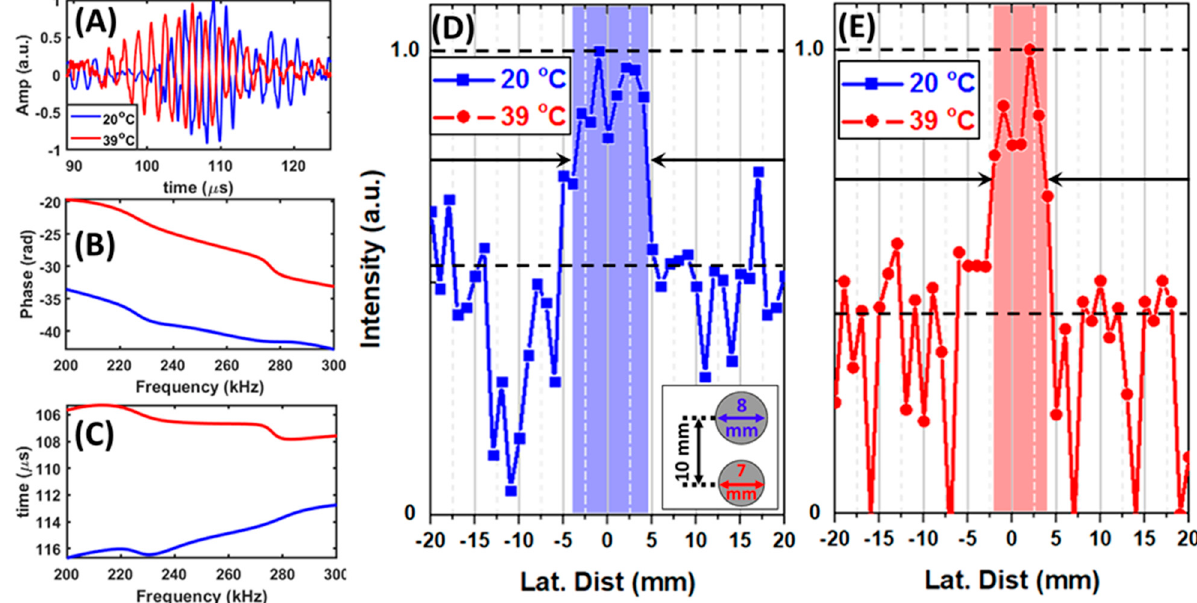
Figure 3. One-dimensional frequency-domain echo-intensity mode detection of two 3D printed ABS plastic rods in ambient water. The rods were located along the Y - (lateral) axis (Figure 2). The 7 mm diameter rod was 60 mm away from the transducer surface. The 8 mm diameter rod was 70 mm away from the transducer. ( A ) Temporal reflection waves detected from the target rods using TSSL at 20 °C and 39 °C. ( B ) The monochromatic components’ phase delay in the range from 0.2 MHz to 0.3 MHz obtained by FFT of the signal showed in ( A ). ( C ) The arrival time of the monochromatic components in the range from 0.2 MHz to 0.3 MHz from the phase information illustrated in ( B ). The results for the one-dimensional echo-intensity mode detection was obtained by FFT of the temporal waves in ( A ) shown by the blue solid line with squares (TSSL at 20 °C) in ( D ) and red dash-dot line with circles (TSSL at 39 °C) in ( E ).